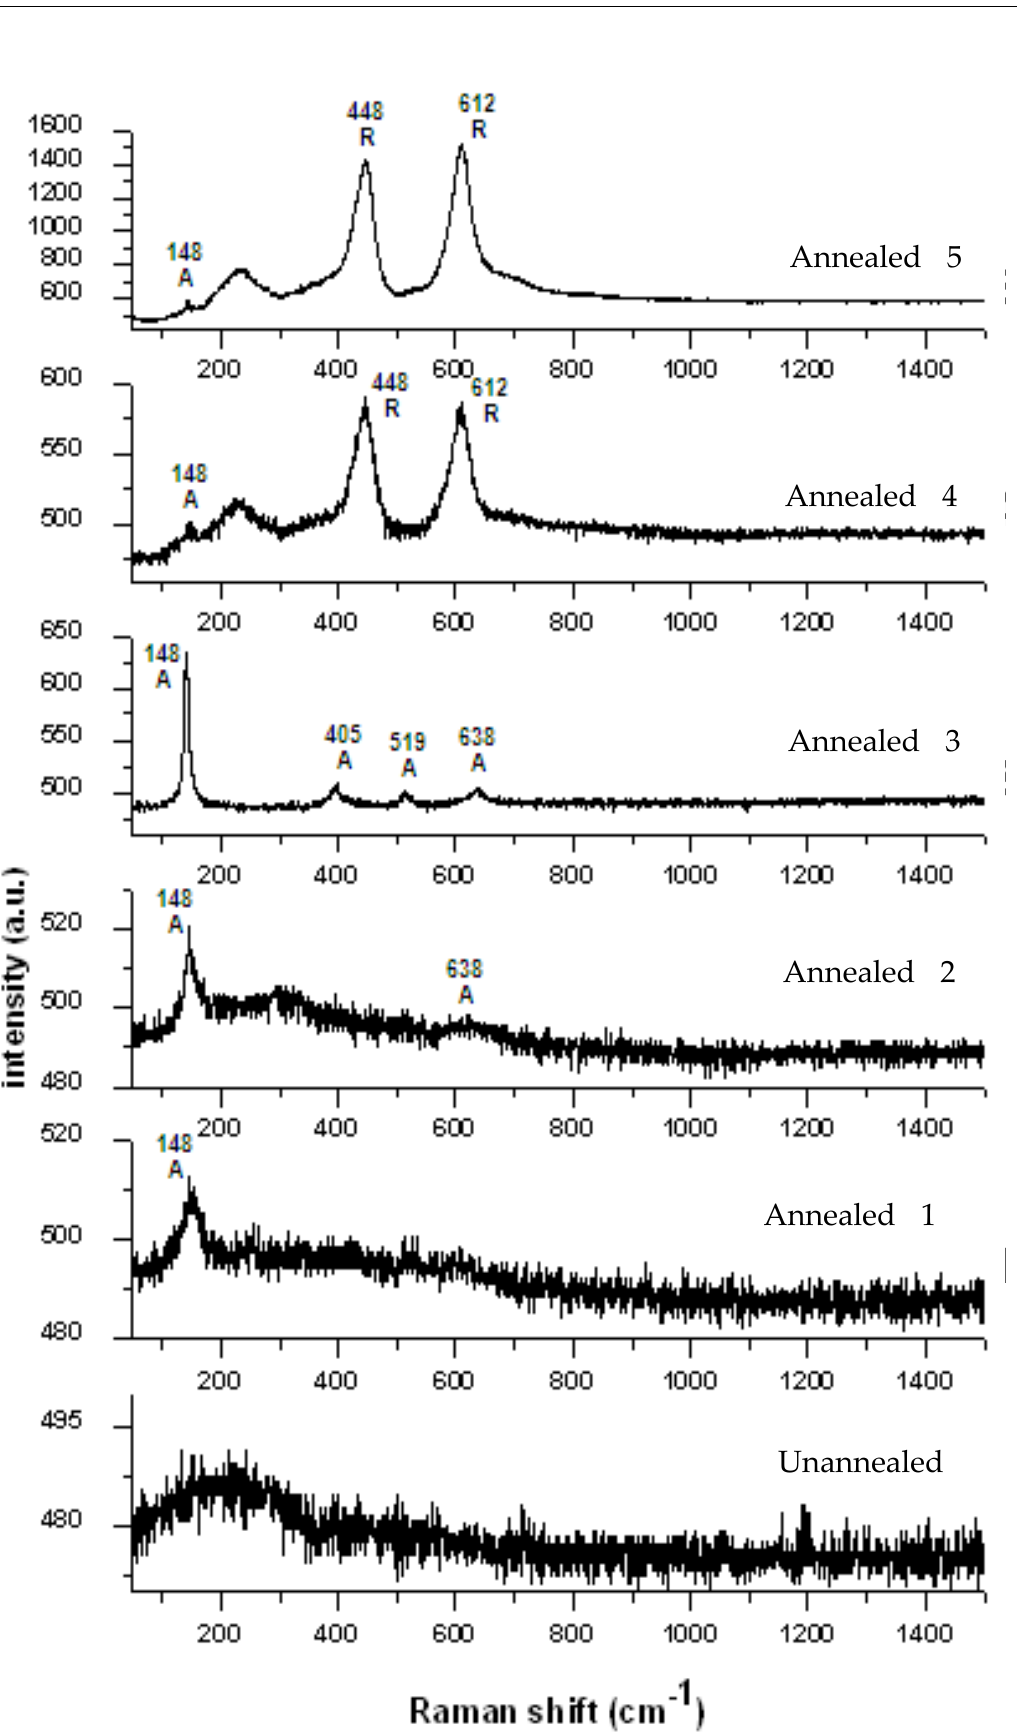
Figure 8. Raman spectra of the sparked titanium nanoparticles films annealed at different temper- atures .